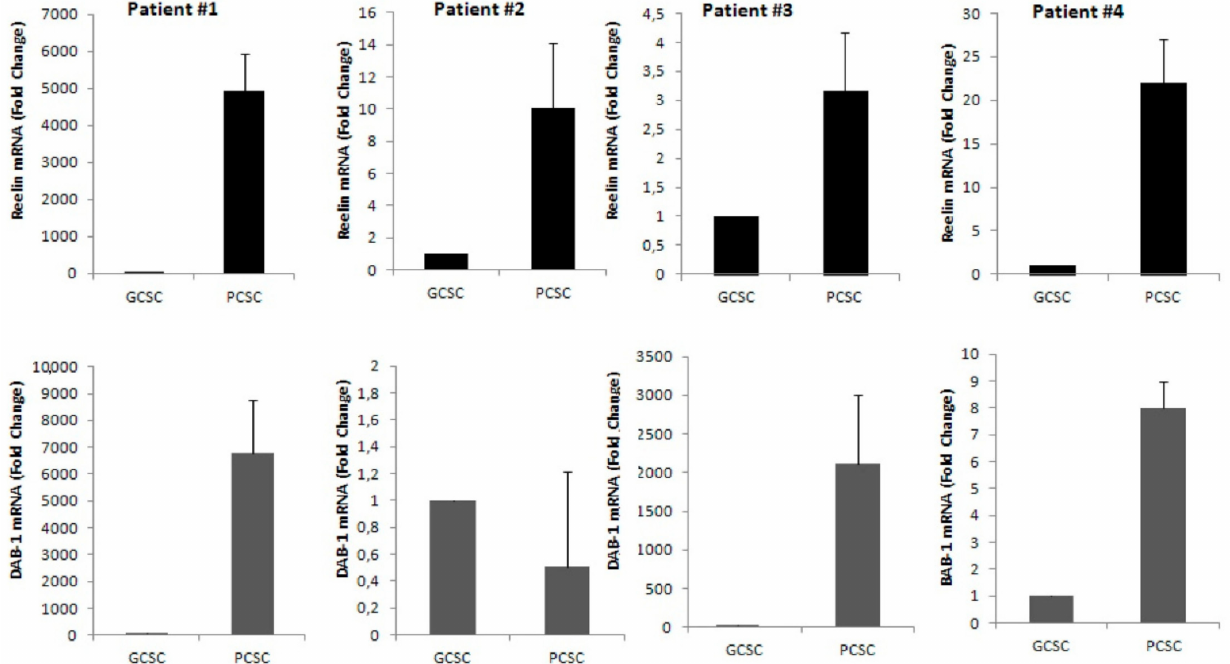
Figure 2. Expression of reelin and Dab1 mRNA by qRT-PCR in GCSCs and PCSCs of four patients. The level of mRNAs of reelin and Dab1 were evaluated by qRT-PCR as described in the Section 2. Upper panels show that mRNA of reelin was higher in all PCSCs compared to GCSCs. Lower panels show that mRNA expression of Dab1 was found higher in three out four examined samples of PCSCs. Bars show the mean of mRNA expression data ± standard deviation from three